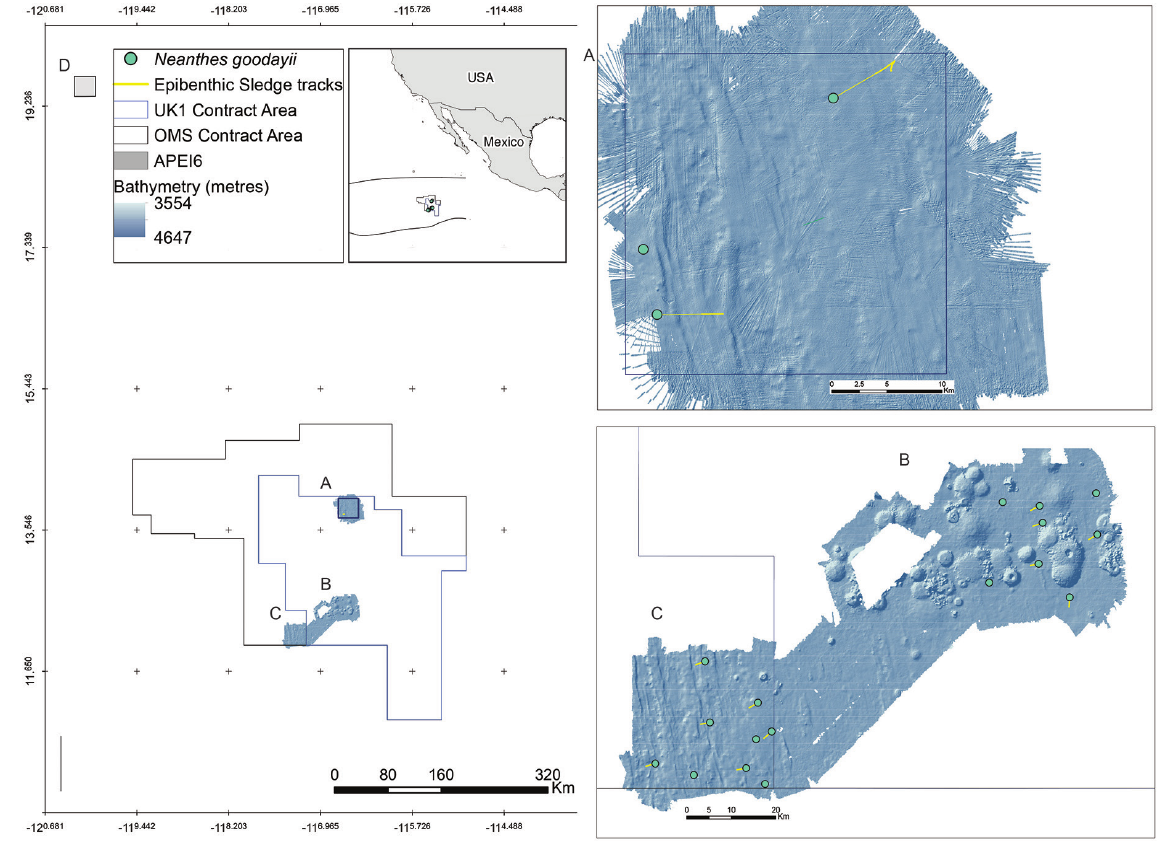
Fig. 1. Sampling sites, showing occurrences of Neanthes goodayi sp. nov. A . UK-1 Stratum-A study area within the UK Seabed Resources UK-1 exploration contract area. B . UK-1 Stratum-B study area within the UK Seabed Resources UK-1 exploration contract area. C . OMS Stratum-A study area, in the Ocean Mineral Singapore (OMS) polymetallic nodule exploration contract area. D . Area of Particular Environmental Interest APEI-6. Inset map showing location of Clarion-Clipperton Fracture Zone in the Central Eastern Pacific. Bathymetric survey data and sampling localities from the AB01 2013 RV Melville survey cruise (MV1313) and AB02 2015 RV Thomas G. Thompson survey cruise (TN319); data courtesy of Craig R. Smith (University of Hawaii), UK Seabed Resources Ltd. and Seafloor Investigations,